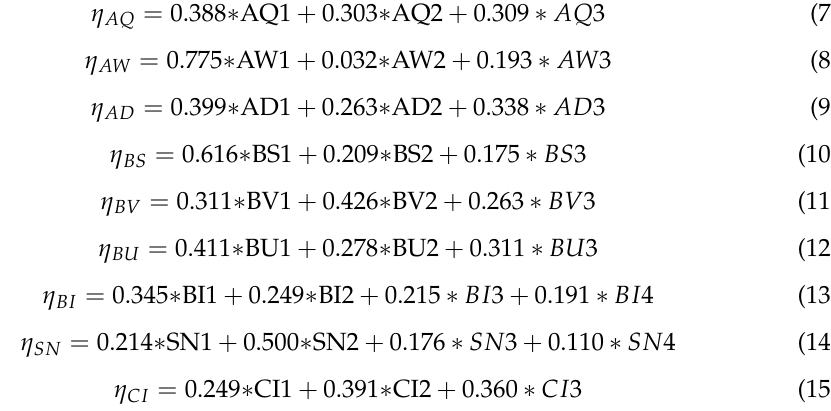
Table 6. Latent attitudinal factors in the CFA. Latent Factor Statement